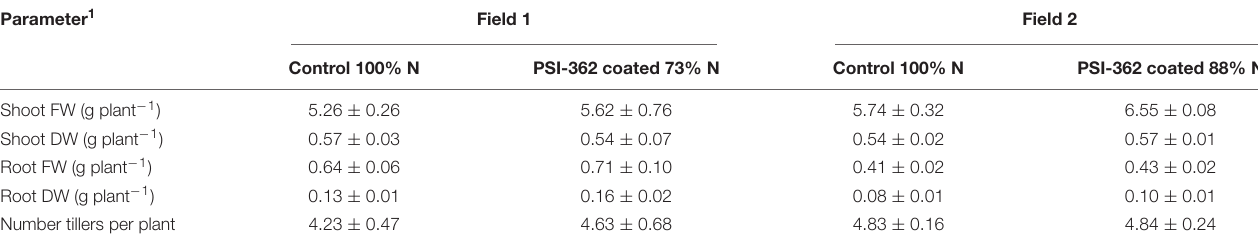
FIGURE 3 | Effect of foliar PSI-362 treatment on grain yield of spring and winter barley varieties growing under 75% N fertilizer rate in 3 consecutive seasons (2016–2018). PSI-362 was applied three times by foliar spray at mid tillering stage (GS22-27), early stem elongation stage (GS30-31), and at the start of the booting stage (GS41-43), and its performance was benchmarked against untreated plants growing under 100% N fertilizer rate. SB1, spring barely cv. KWS Irina; WB1, winter barley cv. KWS Towers; SB2, spring barley cv. Mickle. Chart represents grain yield (t · ha − 1 ) expressed at 20% moisture. Means followed by asterisk indicate statistically significant differences between control and PSI-362 treatment within the same field trial based on t -test at p ≤ 0.05. The horizontal dashed lines represent the average yield value for untreated 100% N (6.24 t · ha − 1 ) and foliar PSI-362 75% N (6.57 t · ha − 1 ). Number of plots harvested per field trial ( n ≥ 5). TABLE 1 | Effect of PSI-362 coated CAN + S fertilizer on phenotypic parameters in barley crop (cv. Gangway) 22 days after application. Parameter 1 Field